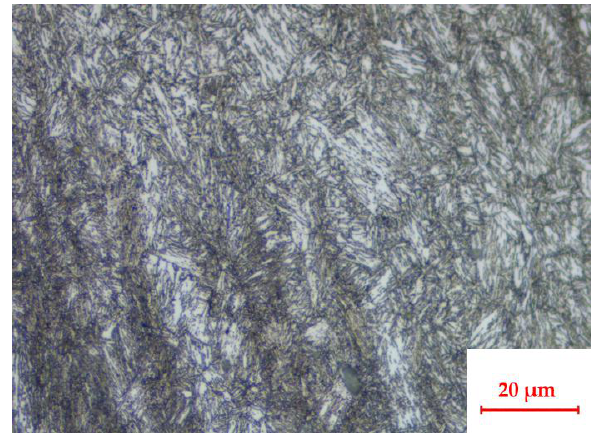
Figure 3. Microstructure of 7% nickel alloy steel. Table 3. The chemical composition of welding consumables [13].